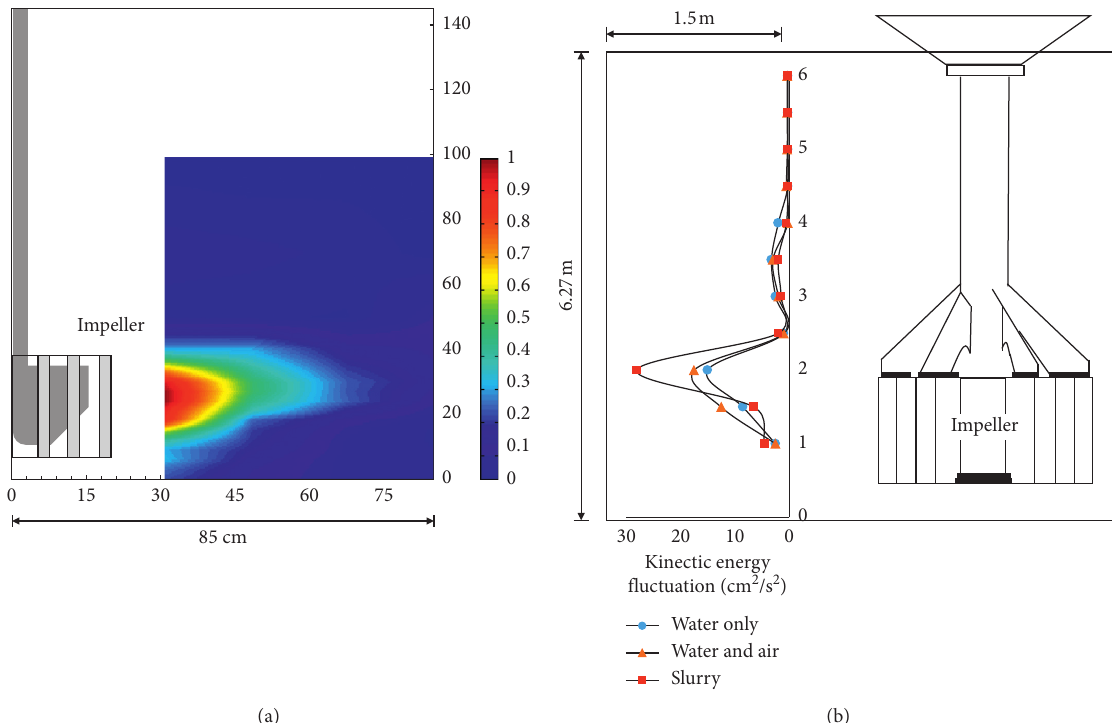
Figure 6: Turbulence distribution indicating shear rate distribution in a (a) 3m 3 flotation cell operating with slurry and (b) 300 m 3 flotation cell operating with water, water and air, and slurry [46].